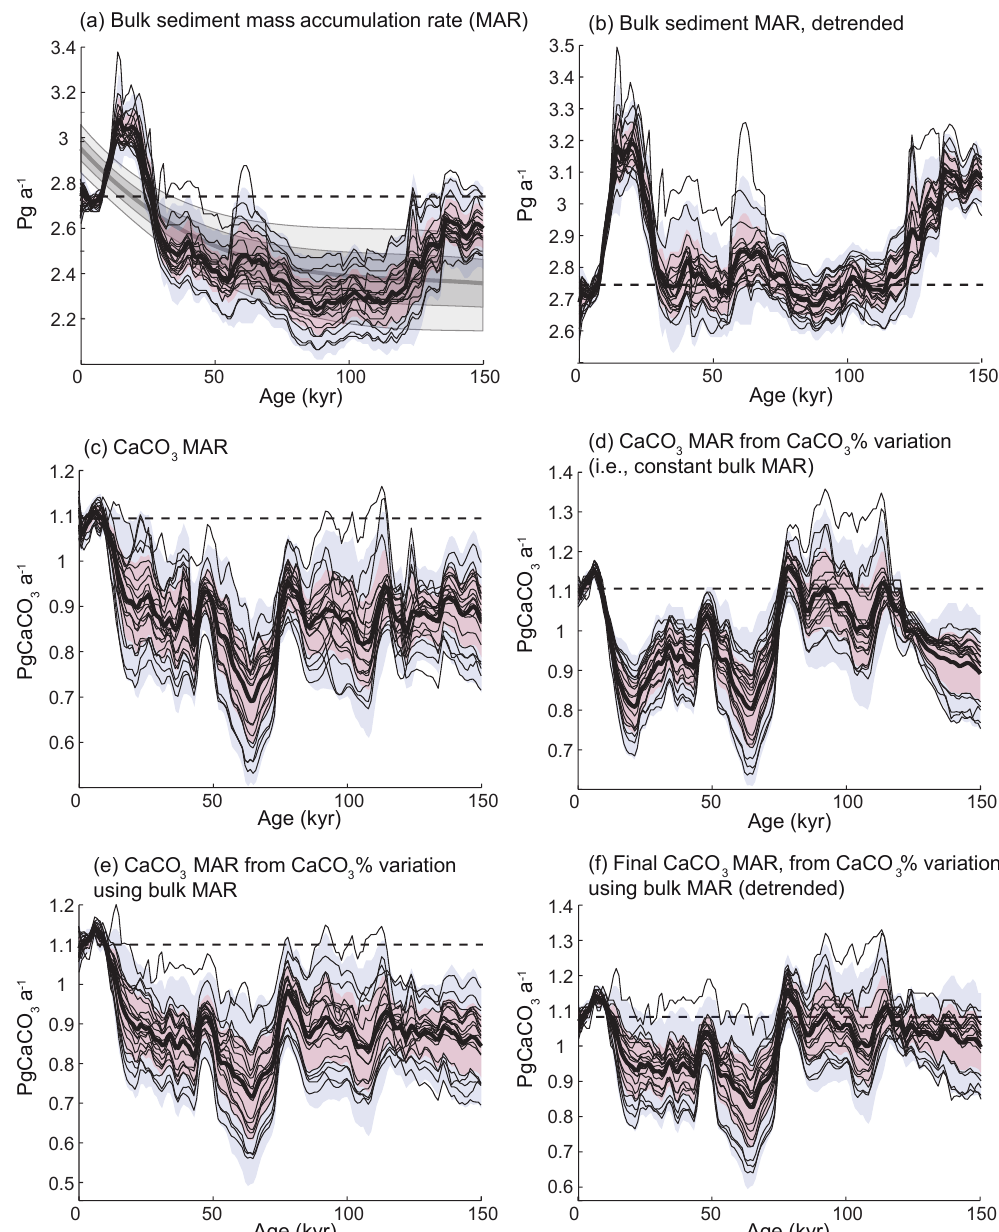
Figure 5. CaCO 3 MAR time series, considering different aspects of variability. (a) Bulk sediment MAR time series distribution based on the 20 province-map scenarios (mean, black line; ± 1 σ , red area; ± 2 σ , blue area), and the distribution of the long-term trend correction for each province map (mean, black line; ± 1 σ , dark grey; ± 2 σ , light grey) using a least-squares spline model. (b) Bulk sediment MAR as in panel (a) but with the modeled long-term trend removed. (c) Global CaCO 3 MAR reconstruction without detrending. (d) Global CaCO 3 MAR reconstruction calculated only from variations in CaCO 3 concentration, assuming a constant bulk sedimentation rate. (e) Global CaCO 3 MAR reconstruction obtained from the bulk MAR and variations in CaCO 3 concentrations. Panel (f) is the same as (e) but with MAR corrected for the long-term trend. In all panels, the thin black lines correspond to the 20 individual province-map scenarios. The modern map used for all calculations corresponds to Fig.